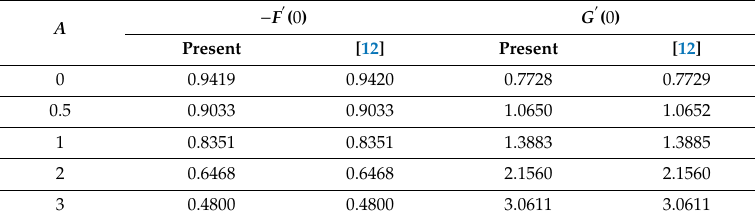
Table 1. Comparison of values of F (cid:48) ( 0 ) and G (cid:48) ( 0 ) obtained by Rahman and Andersson [12] for various suction-strength parameters.